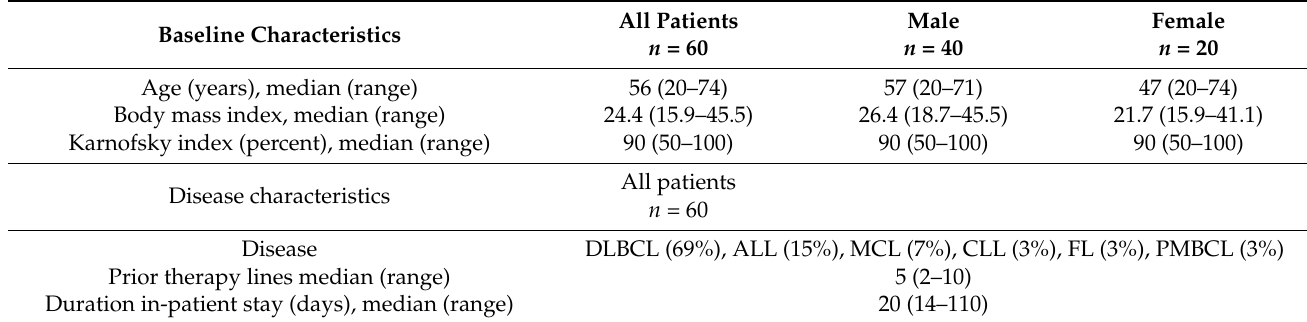
Table 2. Baseline and disease characteristics.